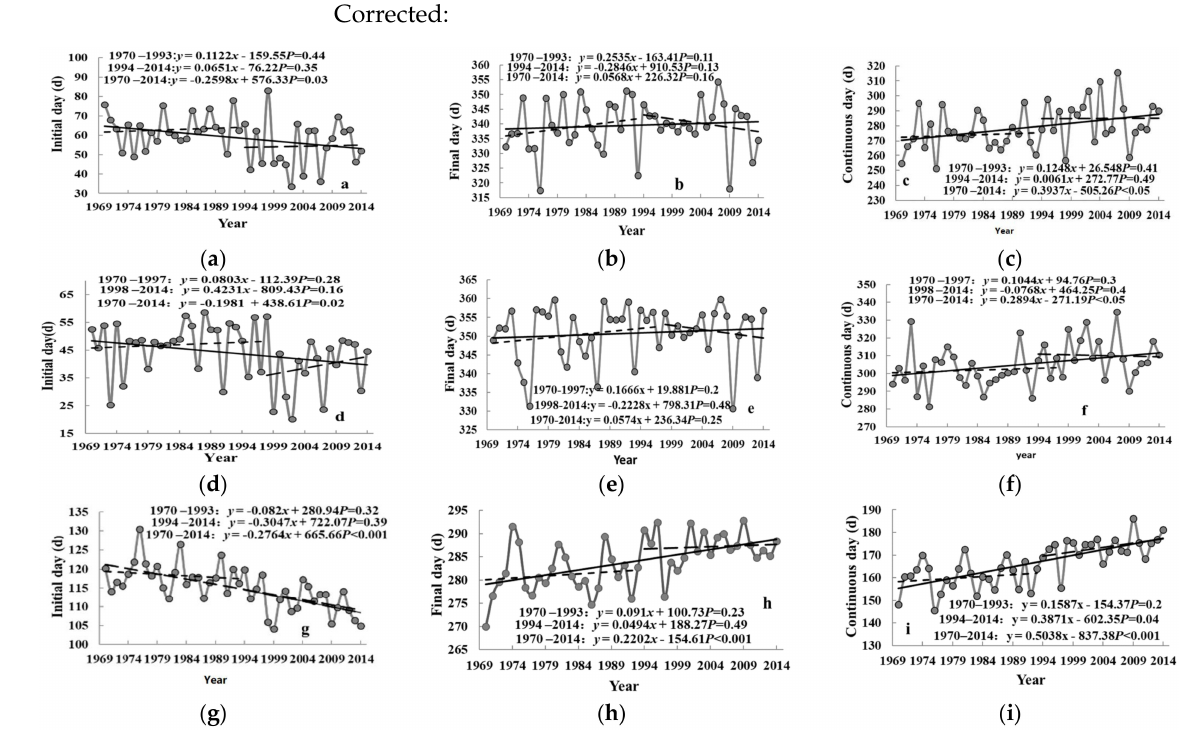
Figure 9. Interannual variation characteristics of the initial day, the final day, and the continuous days of an accumulated temperature of ≥ 5 ◦ C in the northern subtropical zone ( a – c ), mid-subtropical zone ( d – f ), and plateau climate zone ( g – i ) of the Yangtze River Basin during 1970–2014. The authors apologize for any inconvenience caused and state that the scientific conclusions are unaffected. The original publication has also been